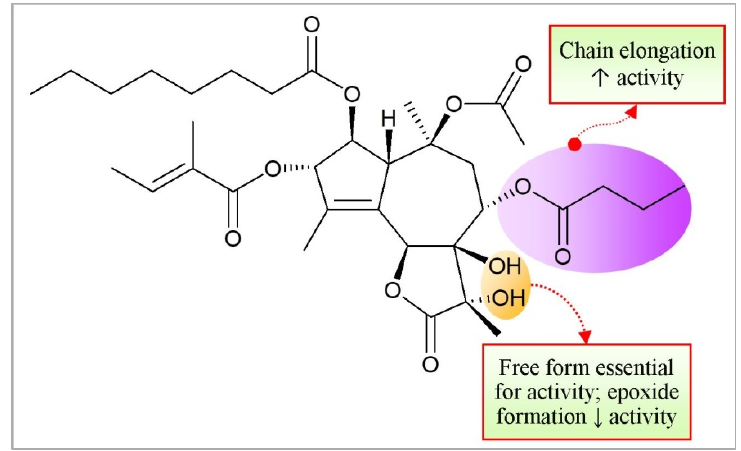
Figure 15. SAR of thapsigargin.